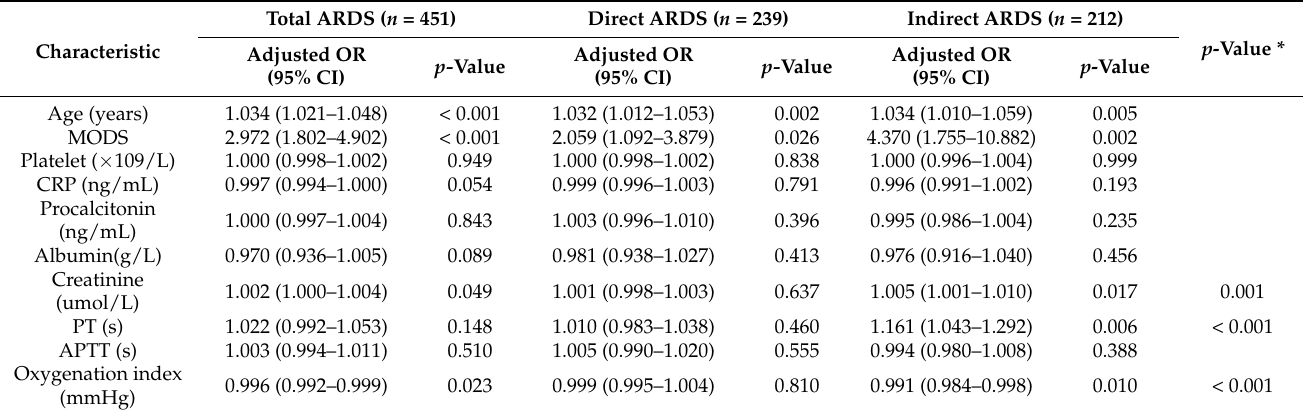
Table 3. Independent predictors of 28-day mortality of direct and indirect ARDS.